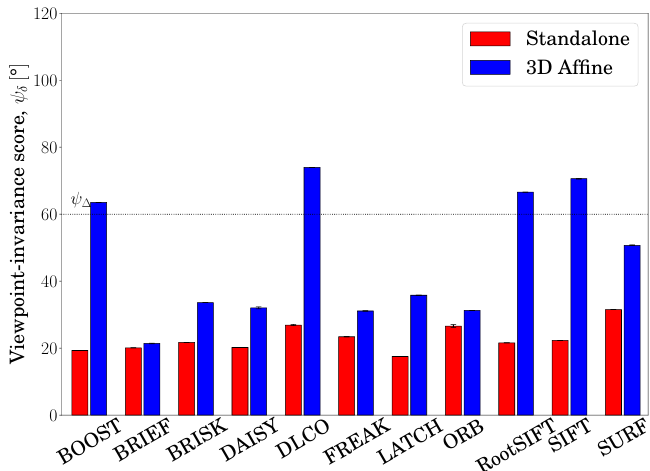
Figure 13. Viewpoint invariance for each descriptor intermixed with the SURF [20] detector. Eleven different descriptors were evaluated, with four of them achieving and one closely approaching the targeted viewpoint invariance threshold, ψ ∆ , after being wrapped in the proposed embedding (blue bars). On the other hand, all standalone descriptors (red bars) missed the target. This figure utilizes the data from the ‘C. T. Crunch’ dataset and the NP3 camera. The rest of the data is presented in later parts of Section